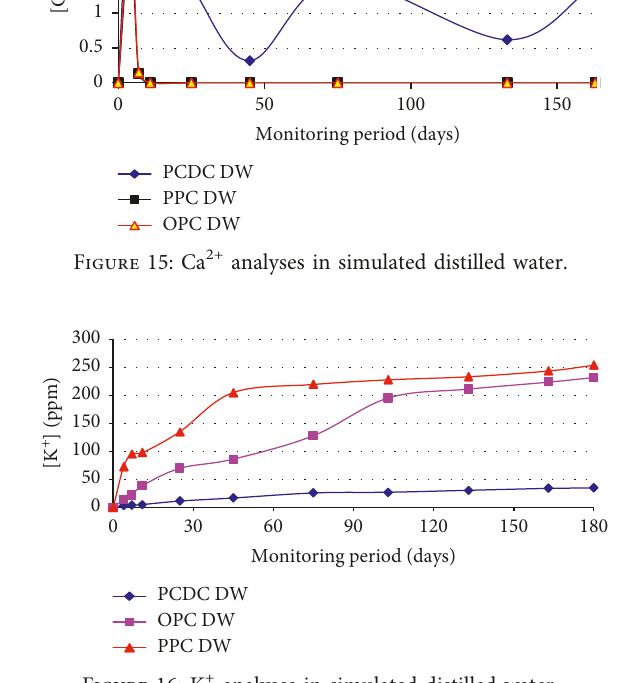
Figure 16: K + analyses in simulated distilled